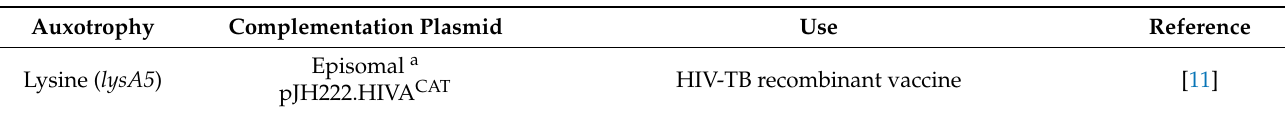
Table 1. Auxotrophic strains of M. bovis